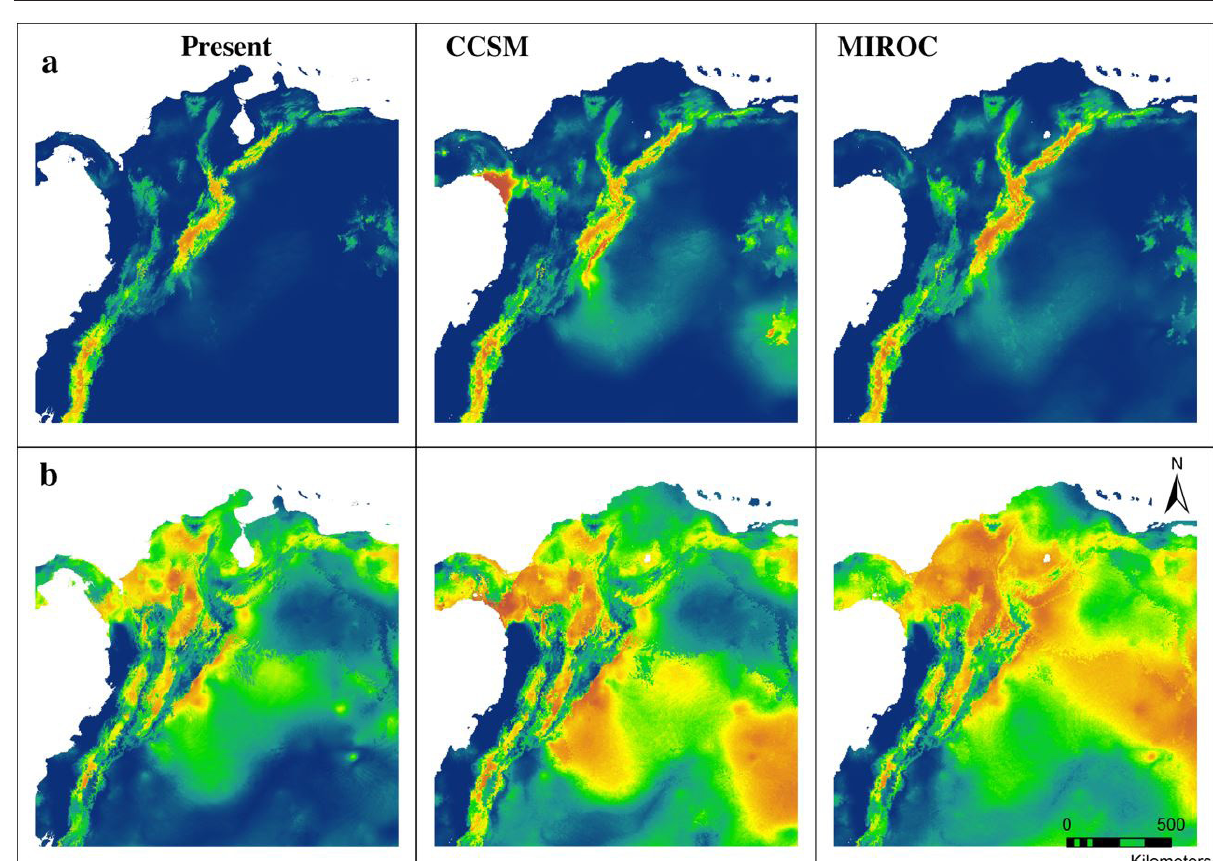
Figure 1. Species distribution models of two selected frog species, one montane ( Dendropsophus molitor , Fig. 1a) and one lowland ( Leptodactylus fuscus , Fig. 1b ), derived from present distributional records and projected onto two general circulation models of environmental conditions during the Last Glacial Maximum (LGM) 21,000 years ago, the Community Climate System Model (CCSM, left) and the Model for Interdisciplinary Research on Climate (MIROC, right). Warmer colors show higher habitat suitability (see Methods for details). Similar graphics with species distribution models and retrojections for the other 12 species are in the supplemental material, with highland species shown in Fig. S3 and lowland species in Fig.